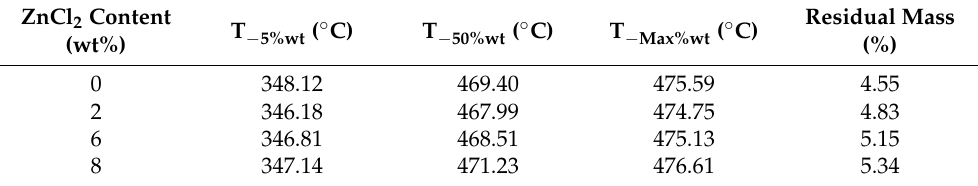
Figure 12. ( a ) TGA and ( b ) DTG thermogravimetric of EVA/CWF composites at different ZnCl 2 con- tents. Table 3. Data of T -5%wt , T -50%wt , T -Max%wt and residual mass of EVA/CWF composites at different ZnCl 2